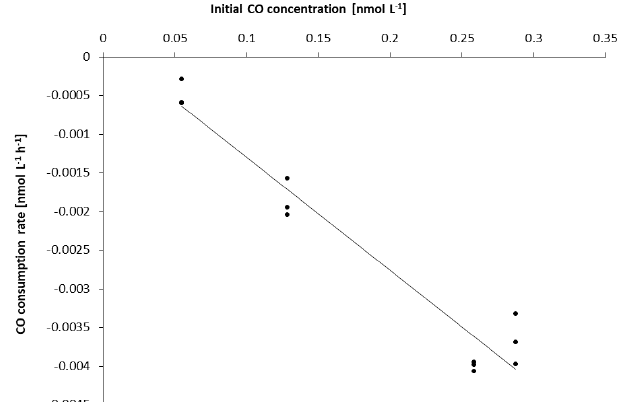
Figure 2. Initial CO concentrations plotted against overall con- sumption rates per experiment. All consumption rates depend on the initial CO concentration (i.e. first-order loss; R 2 = 0 . 94 with p < 0 . 05; see also Fig.